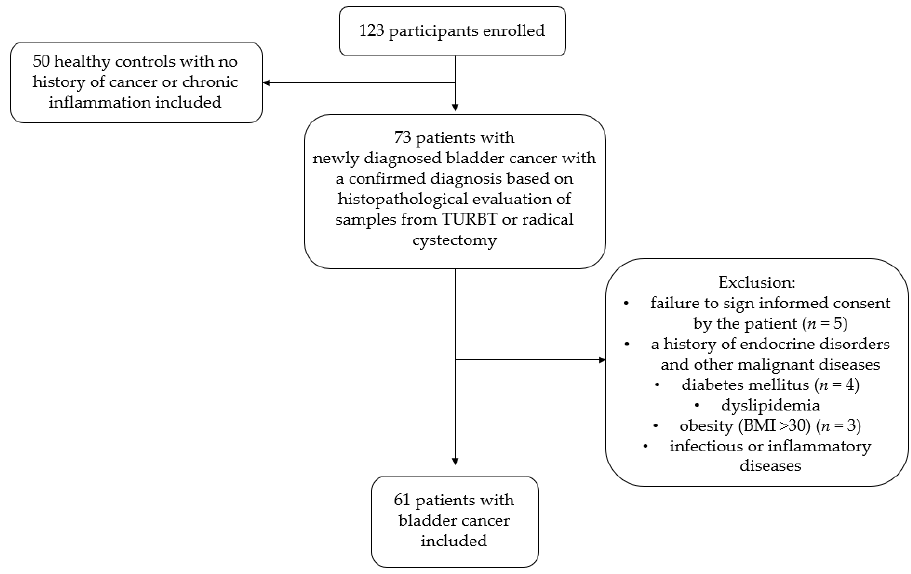
Figure 1. Flowchart of the study recruitment process.